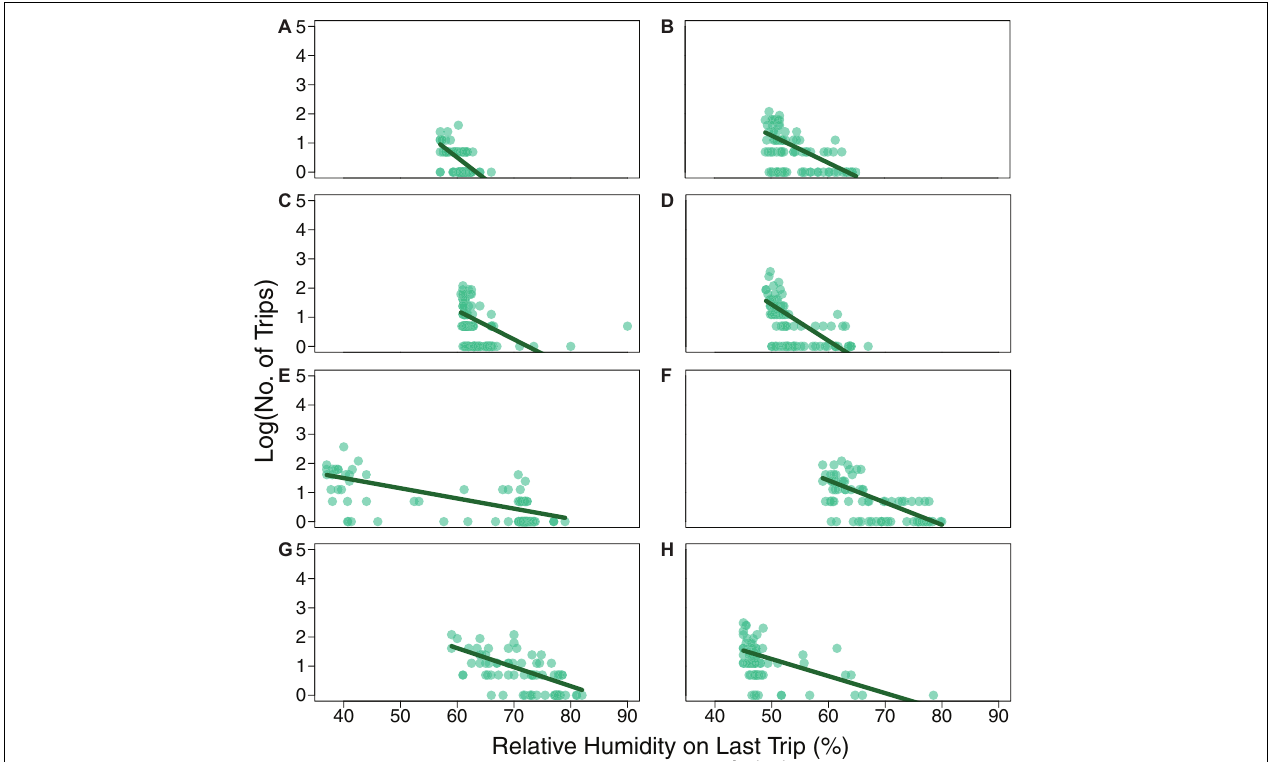
FIGURE 4 | Total number of trips made by each ant as a function of the humidity on its last trip. The dark green line shows the result of the Poisson regression model: log(No. of Trips) ∼ slope × Relative Humidity on Last Trip + intercept (coefficient values in Table 3 ). Each row of two panels shows the data in light green for Day 1 and Day 2 for one colony: (A) Colony 859, August 20, 2017; (B) Colony 859, August 21, 2017; (C) Colony 1107, August 20, 2017; (D) Colony 1107, August 21, 2017; (E) Colony 1242, August 22, 2018; (F) Colony 1242, August 23, 2018; (G) Colony 1368, August 24, 2018; (H) Colony 1368, August 25, 2018.